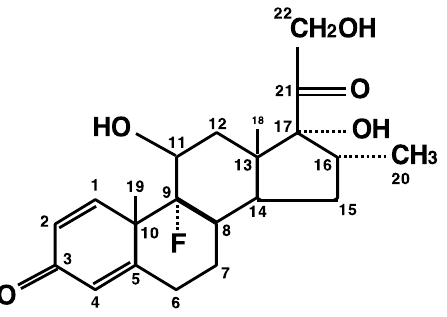
Figure 1. Chemical structure of dexamethasone. Dexamethasone (C 22 H 29 FO 5 : PubChem CID: 5743) is a synthetic pure glucocorticoid fluorinated at carbon-9 with molecular mass of 392.467 g/mol. Similar to cortisol (hydrocortisone), it has a carbonyl oxygen at carbon-3 and a hydroxyethyl at carbon-21 (as carbon-22). Additionally, it harbors a fluoride (F) at carbon-9 and a methyl at carbon-16 (as carbon-20).